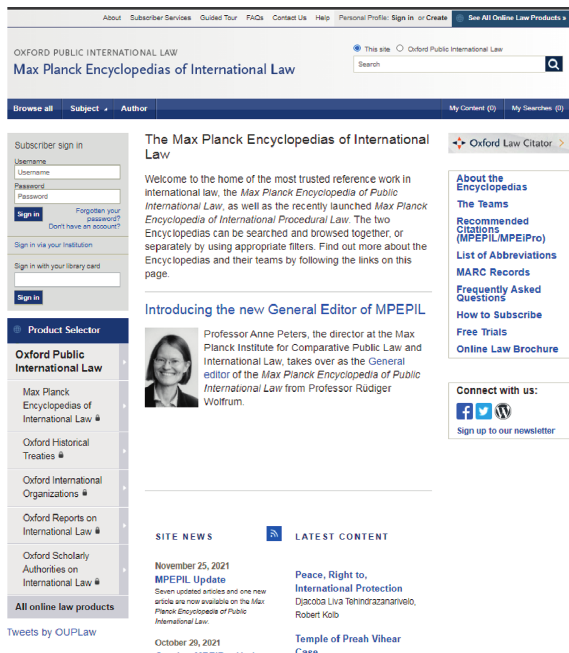
Figure 2: Max Planck Encyclopedia of Public International Law